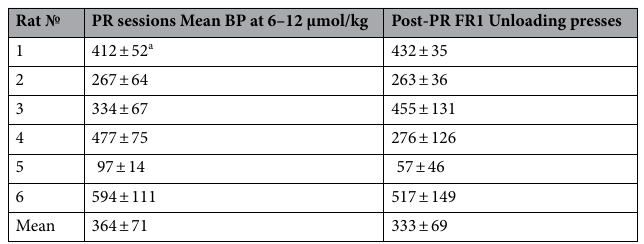
Table 4. BP at two highest cocaine unit doses and the number of unloading presses. a Mean ±